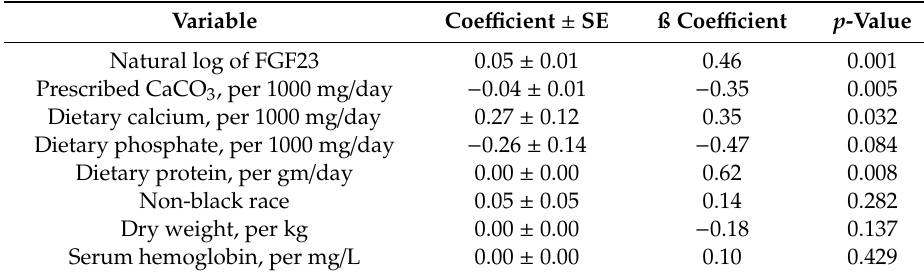
Table 6. Hand-built multivariable model to predict serum calcium (adjusted r 2 = 38%).